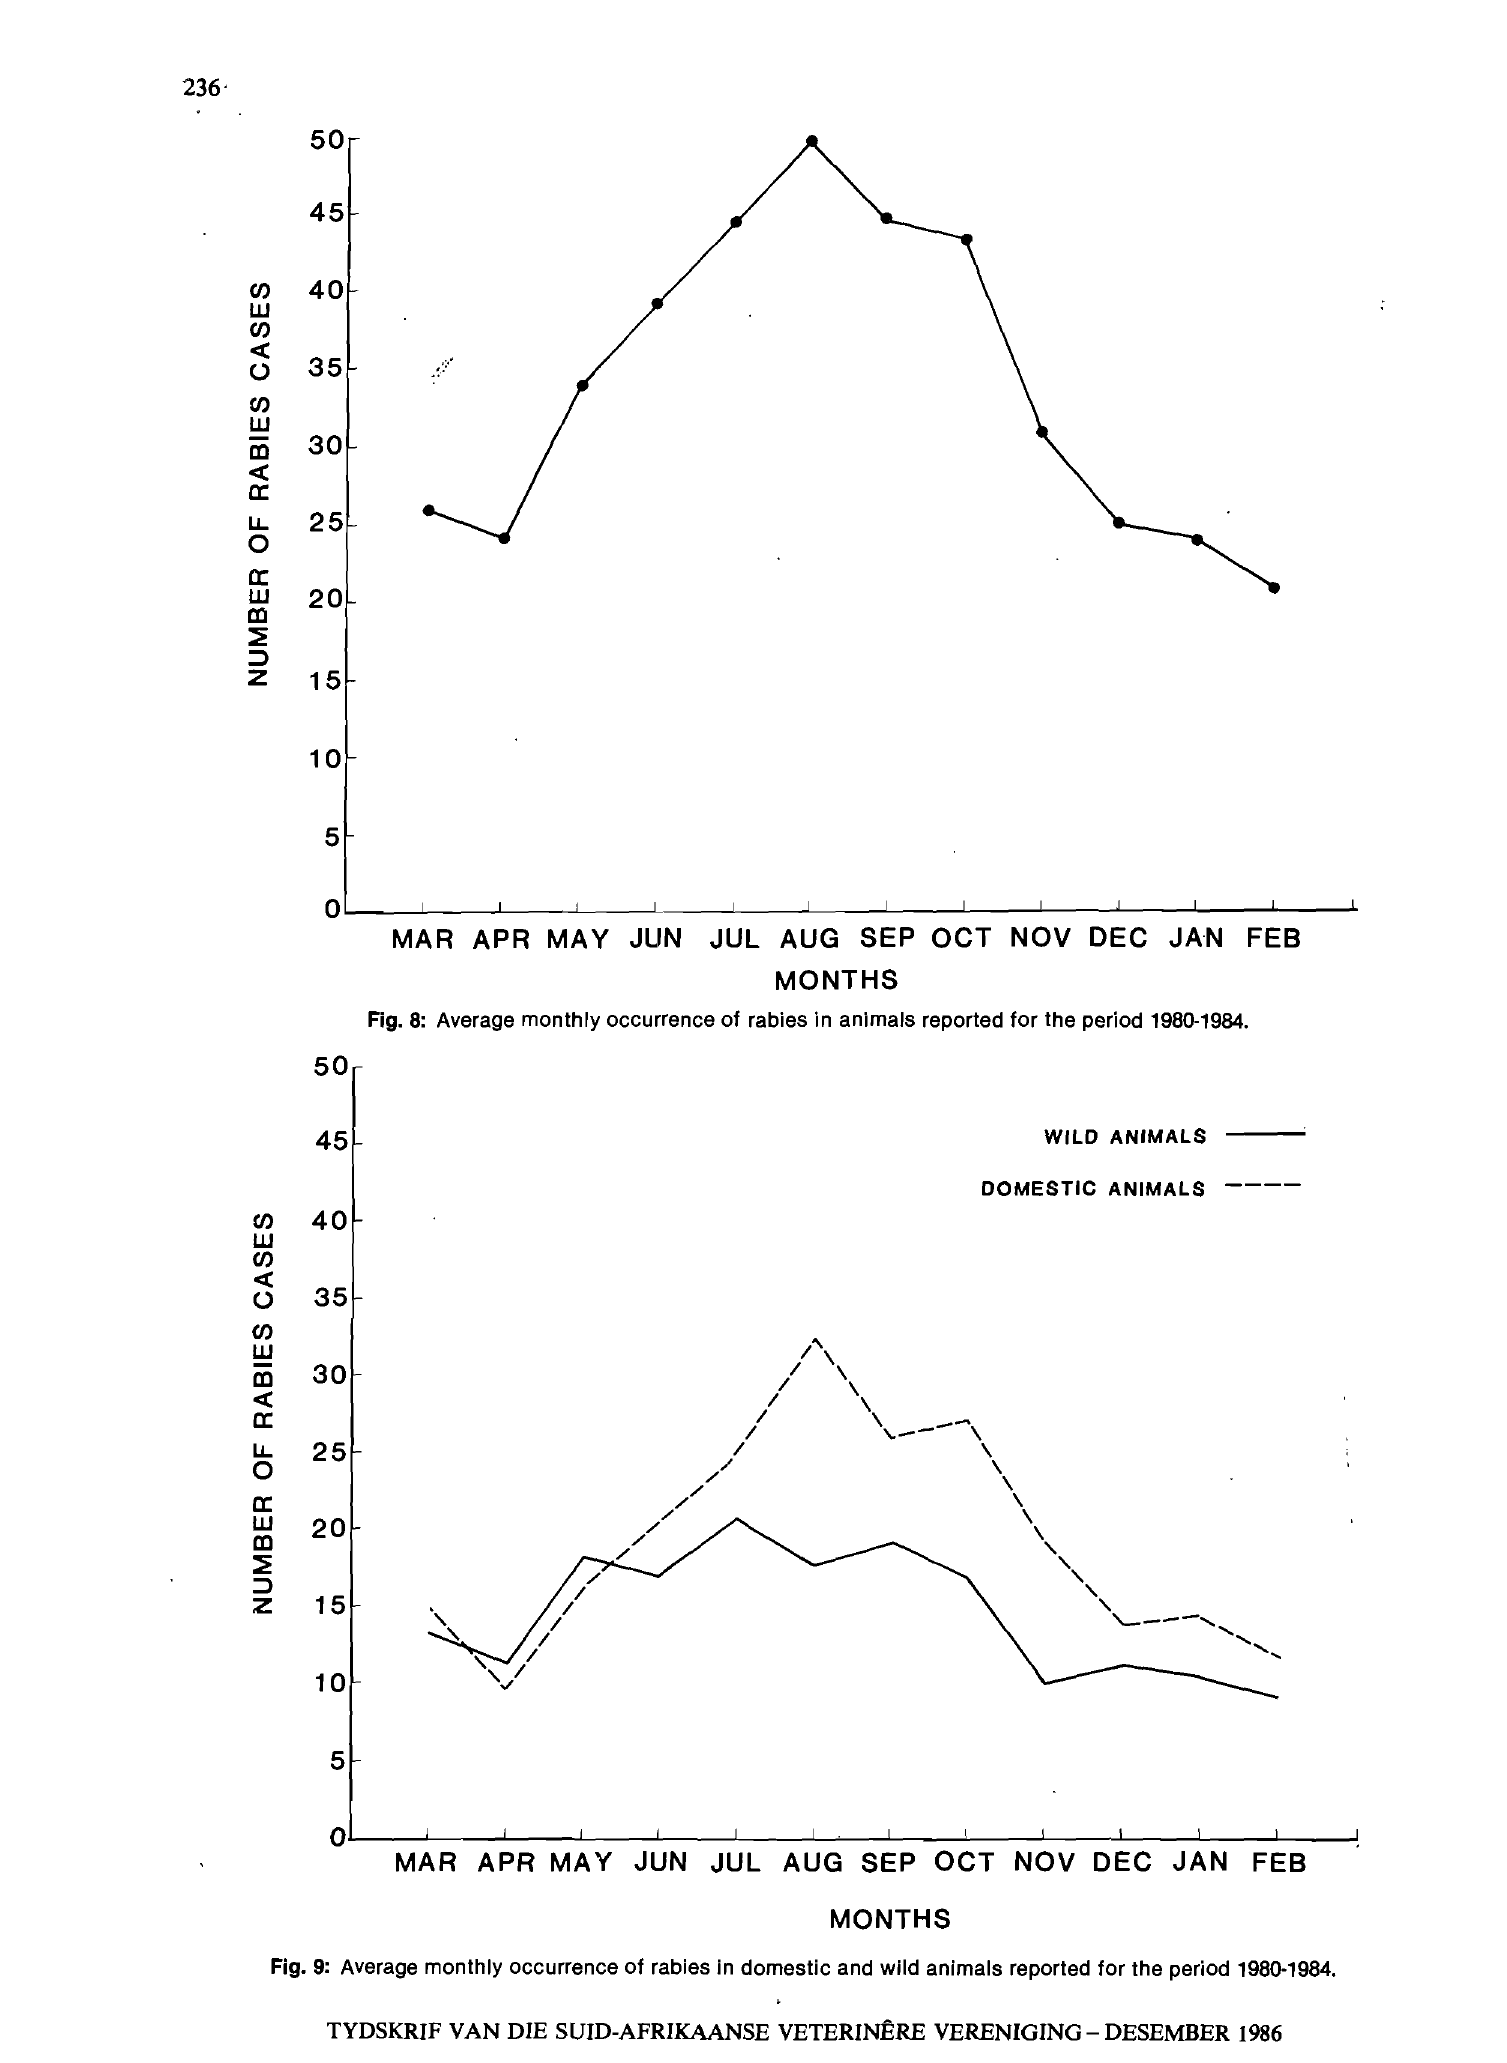
WILD ANIMALS DOMESTIC ANIMALS